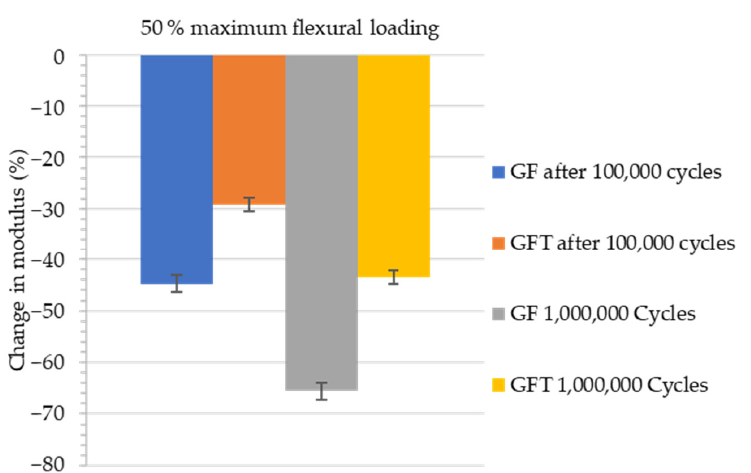
Figure 9. Glass fibre at 50% flexural strength cyclic loading. Samples designated GF and GFT, cycled for 100,000 cycles at 400 N loading for 100,000 and 1 million cycles.